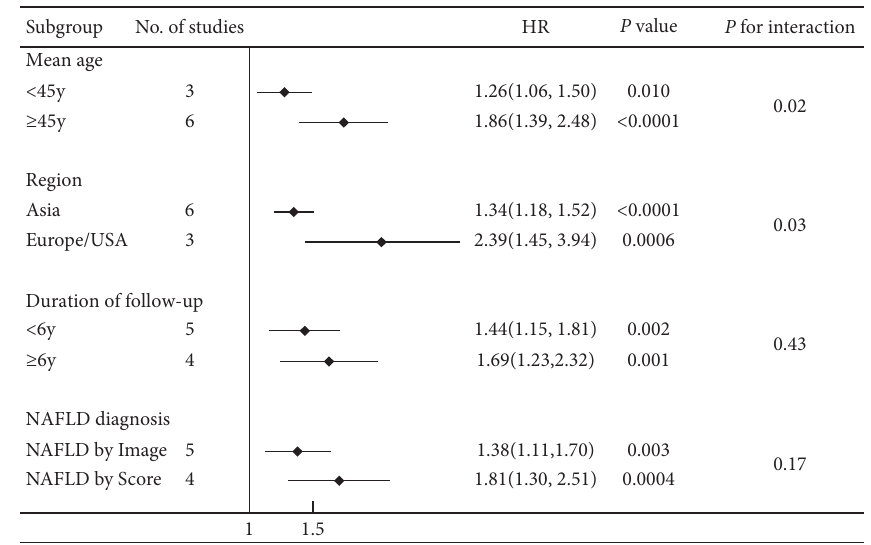
Figure 4: Subgroup sensitivity analyses on studies assessing the association between NAFLD and incident HTN, stratified based on the mean age of participants, geographical regions, duration of follow-up, and NAFLD diagnostic methods, respectively.